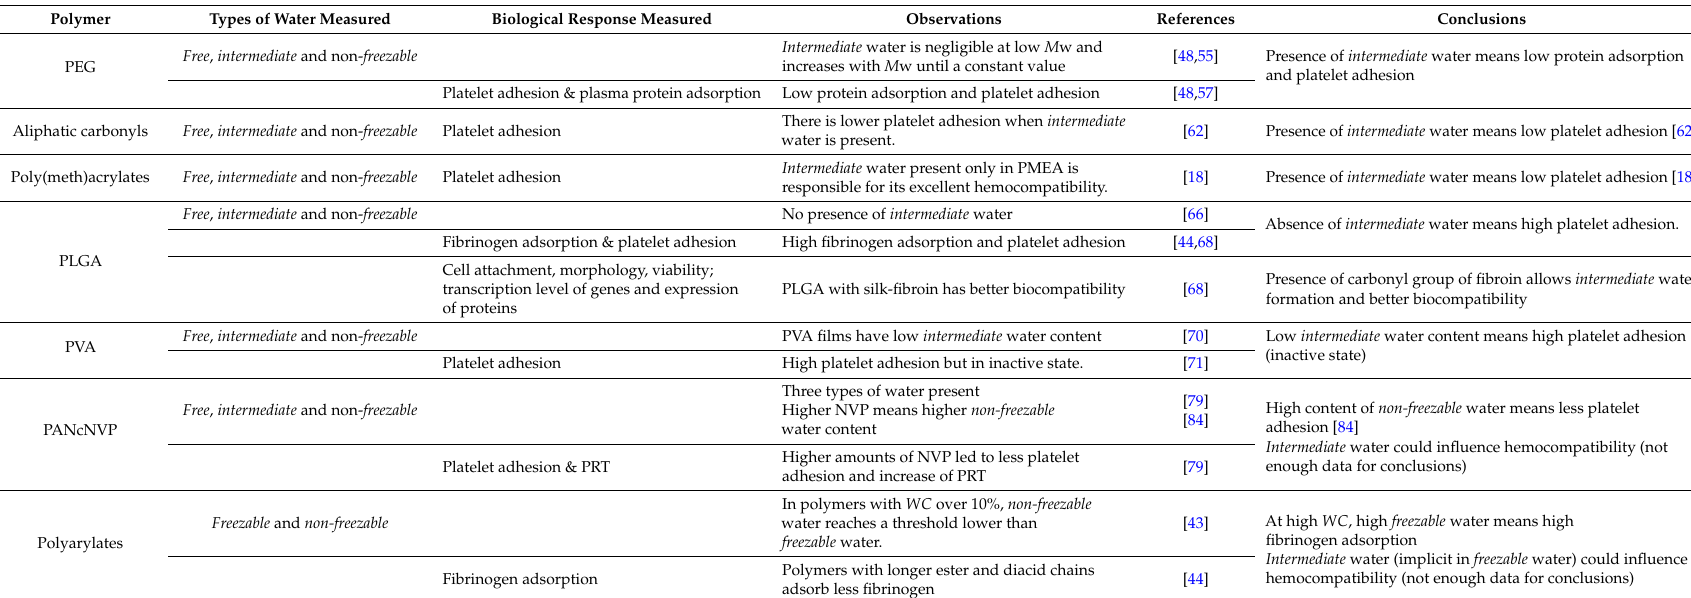
Table 4. Summary of principal observations and conclusions in each